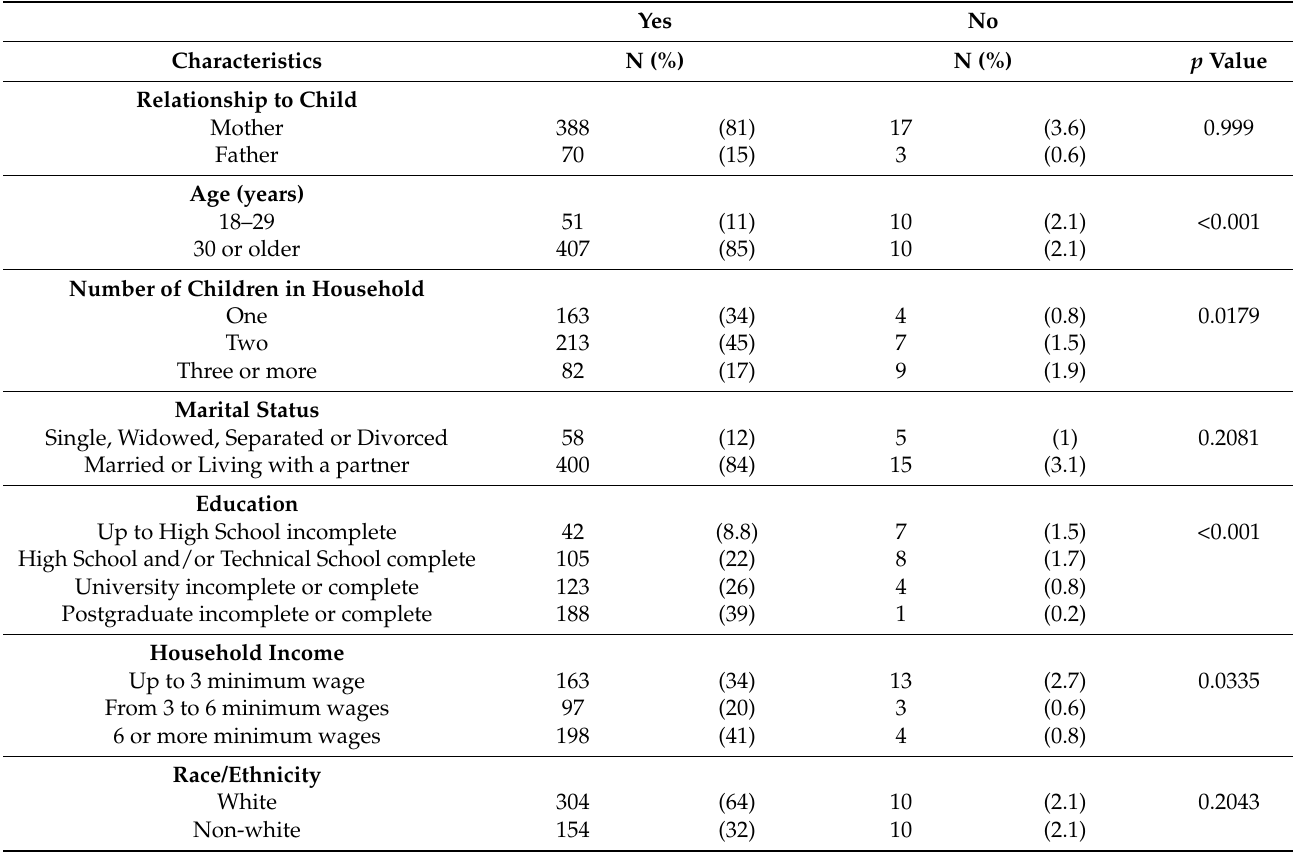
Table 2. Factors associated with COVID-19 vaccine approval (N = 458) and refusal (N = 20) for children among caregivers.